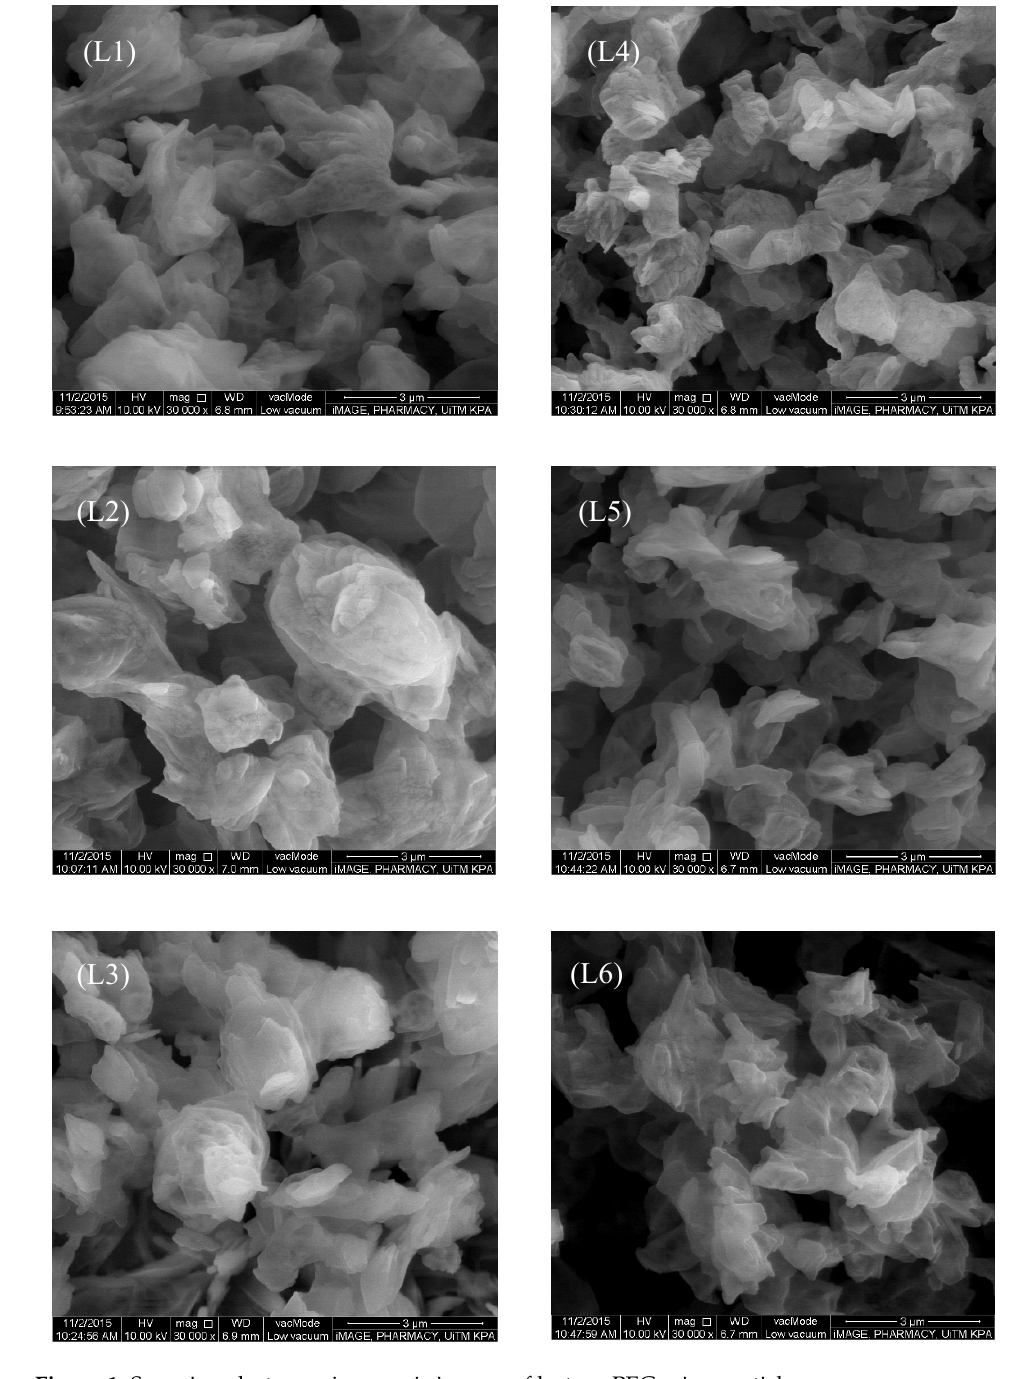
Figure 1. Scanning electron microscopic images of lactose-PEG microparticles.